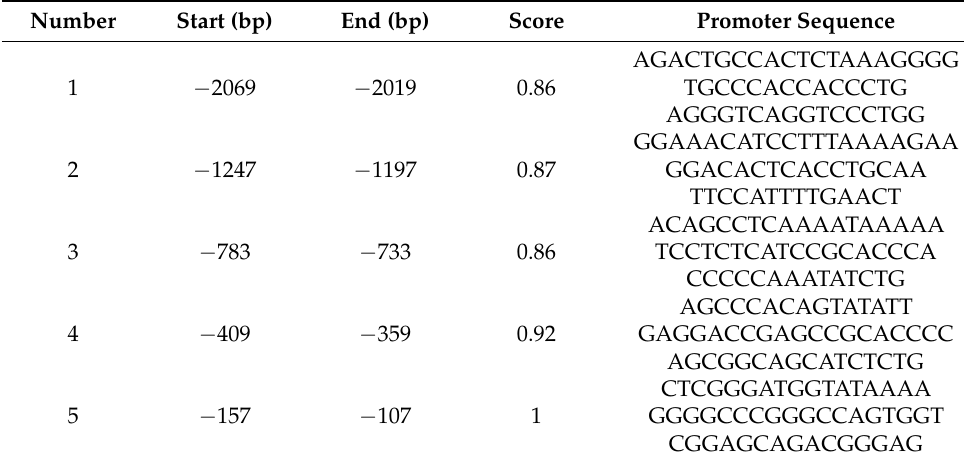
Figure 1. Bioinformatics analysis of 5 (cid:48) flanking region of porcine COL1A1 . ( a ) Schematic representa- tion of the transcription factor-binding sites prediction and promotor structure in 5 (cid:48) flanking region of porcine COL1A1 ; ( b ) CpG islands prediction in 5 (cid:48) flanking region of porcine COL1A1 . Table 3. Predicted promotor sequence in 5 (cid:48) flanking region of porcine COL1A1